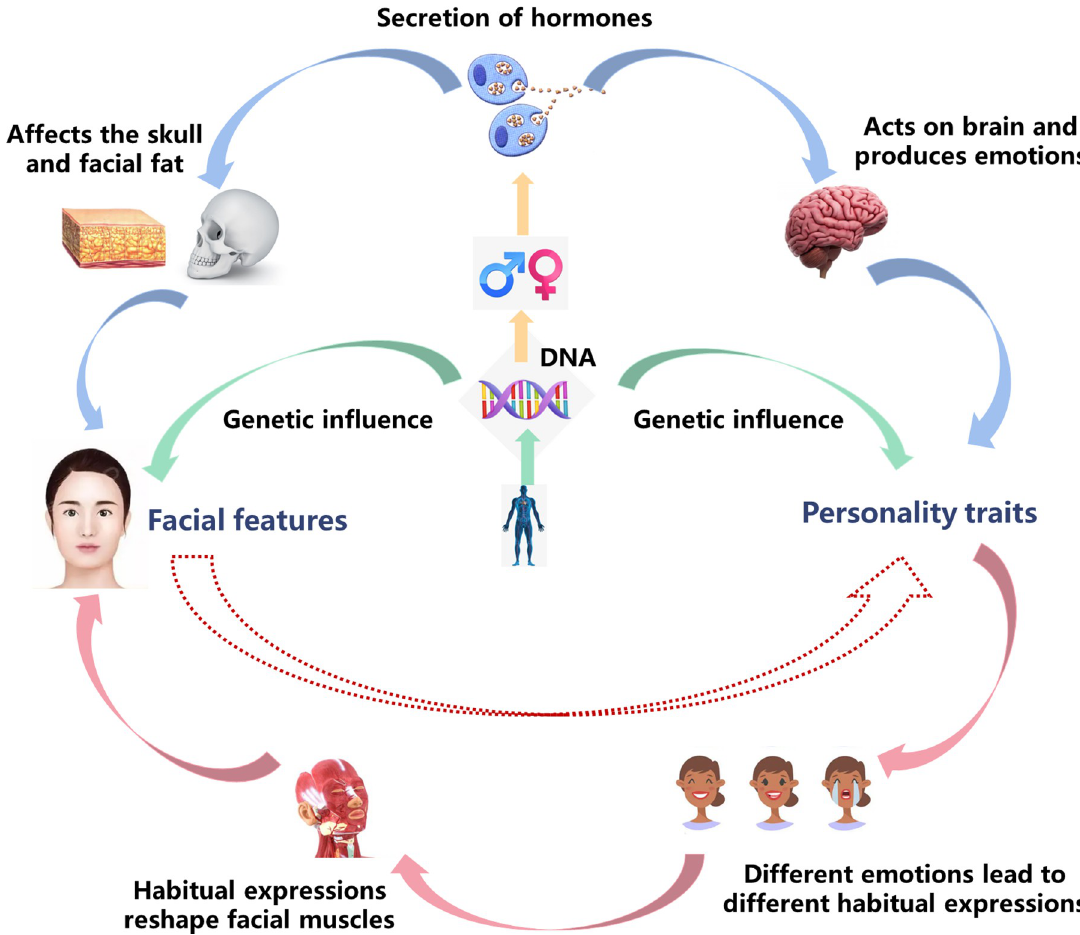
Fig 1. Theoretical support for the correlation between facial features and personality traits. Note : The green arrow represents the effects of genetic influence, the yellow arrow represents the effects of gender dimorphism, the blue arrow represents the neuroendocrine basis, and the pink arrow represents the habitual expressions that reshape facial